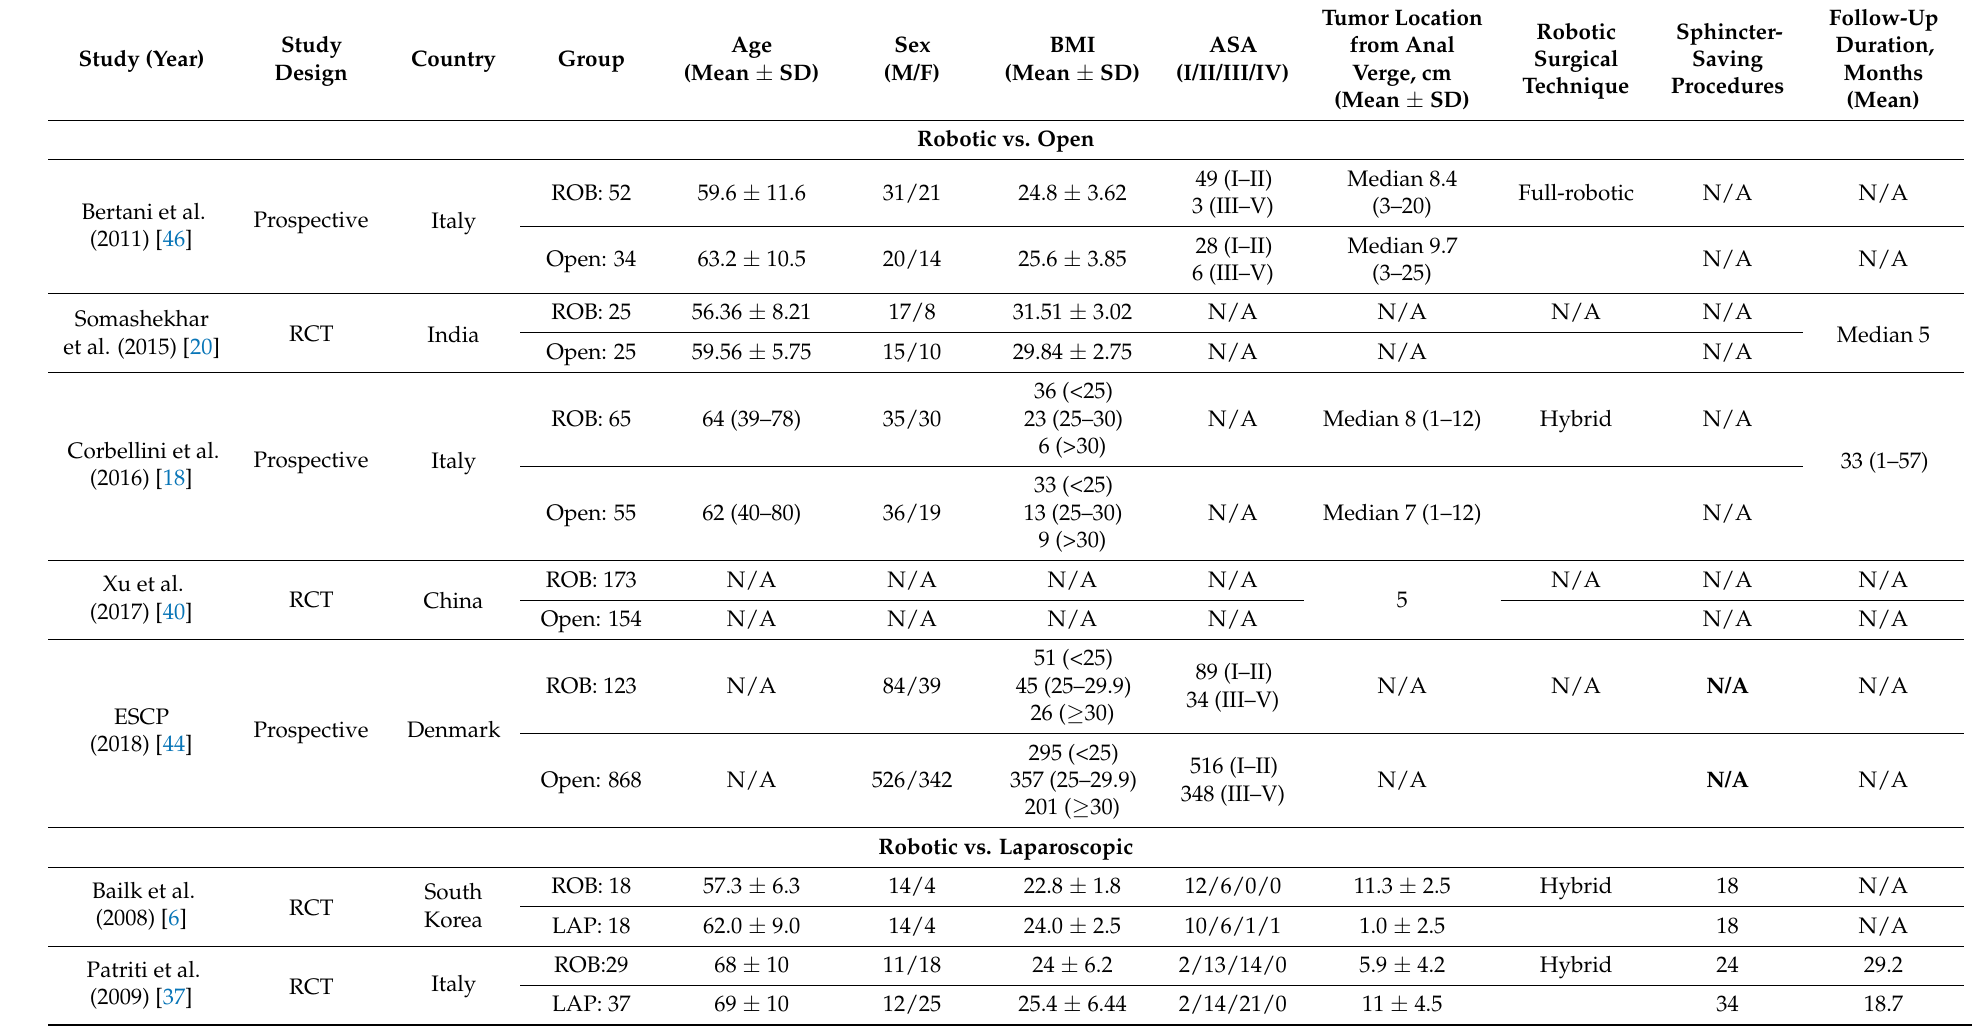
Table 1. Study characteristics of the included studies in the qualitative